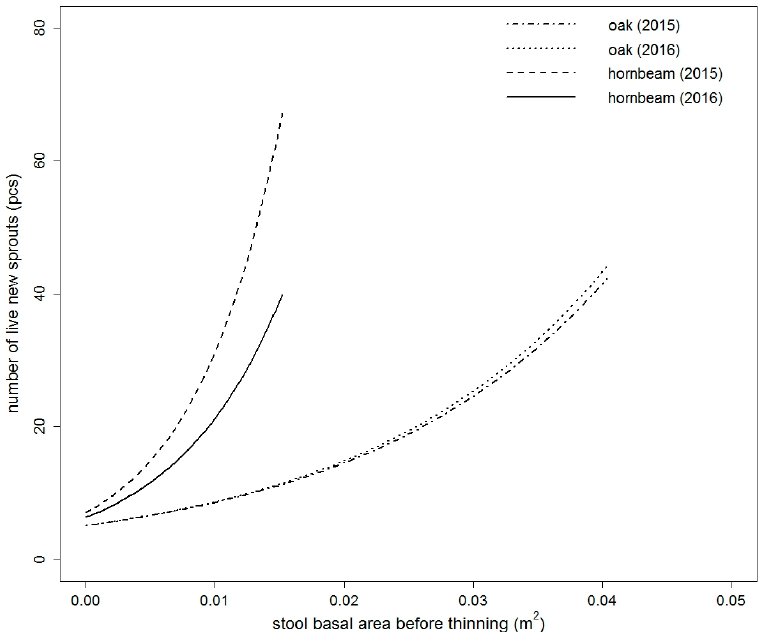
Figure 3. Comparison of fitted values of the live new sprouts model of sessile oak and European hornbeam in both studied years. Models are based on the stool basal area before thinning and thinning intensity (for both species) and indirect site factor and leaf area index (only for European hornbeam) (for the purpose of this figure, thinning intensity = 50% for both species and both years, ISF = 0.1313 for only European hornbeam in both years, LAI = 2.5045 for only European hornbeam in year 2016).